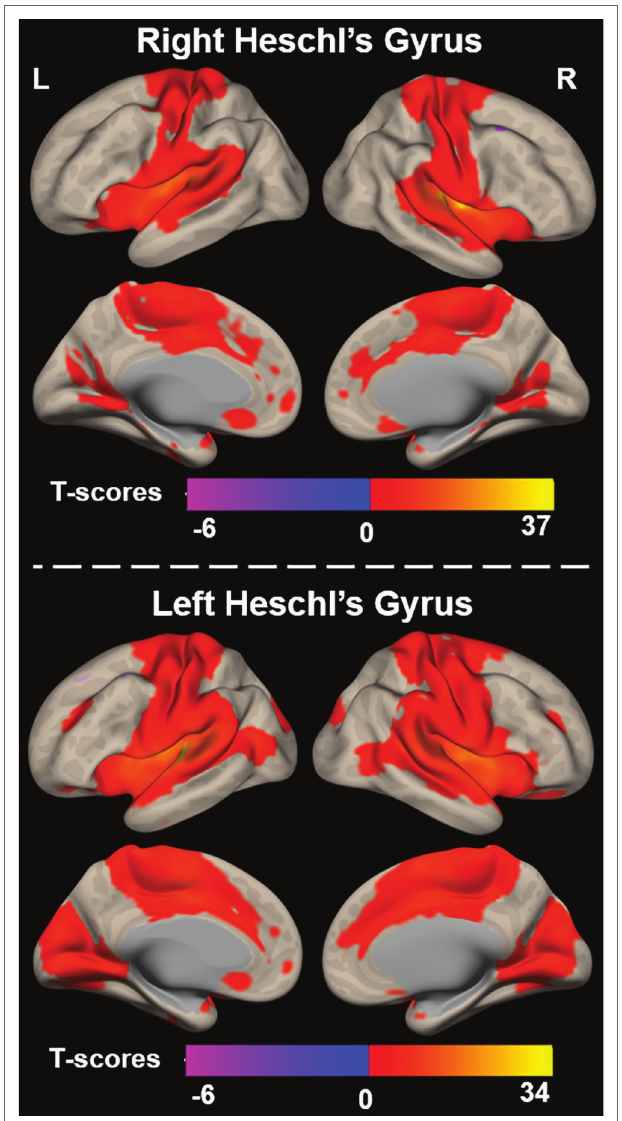
FIGURE 2 | Functional connectivity between right (top) and left (bottom) Heschl’s gyrus and all voxels across the cerebrum, voxelwise p < 0.001 uncorrected, and cluster-level p < 0.05